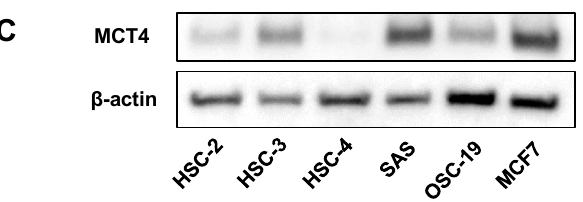
Figure 1. The expression of monocarboxylate transporter 4 (MCT4) in head and neck normal tissues, head and neck cancers, and human oral squamous cell lines. ( A ) Immunohistochemistry analysis of MCT4 in head and neck normal tissue ( a ) and head and neck cancer (HNC) ( b ). Scale Bar=200 μ m . ( B ) Scatterplot of the MCT4-positive areas in the head and neck normal tissues ( n = 11) and head and neck squamous cell carcinoma (HNSCC) ( n = 70). Error bars: mean ± standard deviation (SD). There was a significantly increased expression of MCT4 in the HNSCC samples ( p < 0.0001). ( C ) Expression of MCT4 in human oral squamous cell carcinoma cell lines (HSC-2, -3, -4; SAS, OSC-19) and a human breast cancer cell line (MCF7) analyzed by western blotting.